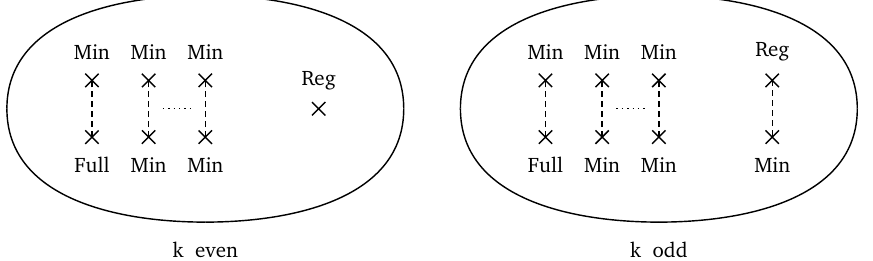
Figure 17: Class S configurations for the quivers in (47). In both cases the UV curve is a sphere, quivers with an even or odd number of gauge nodes are distinguished by the puncture structure.